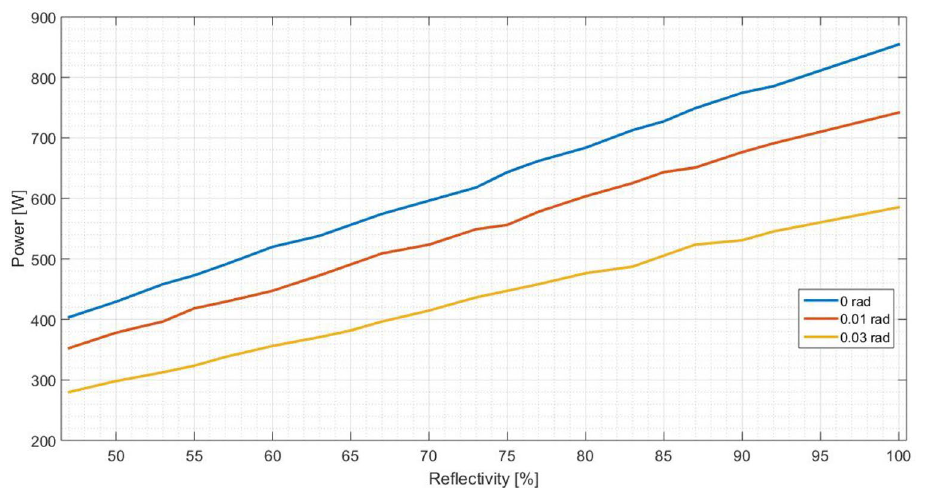
Figure 13. Output power in function of the reflectivity of the parabolic concentrator, for different optical error